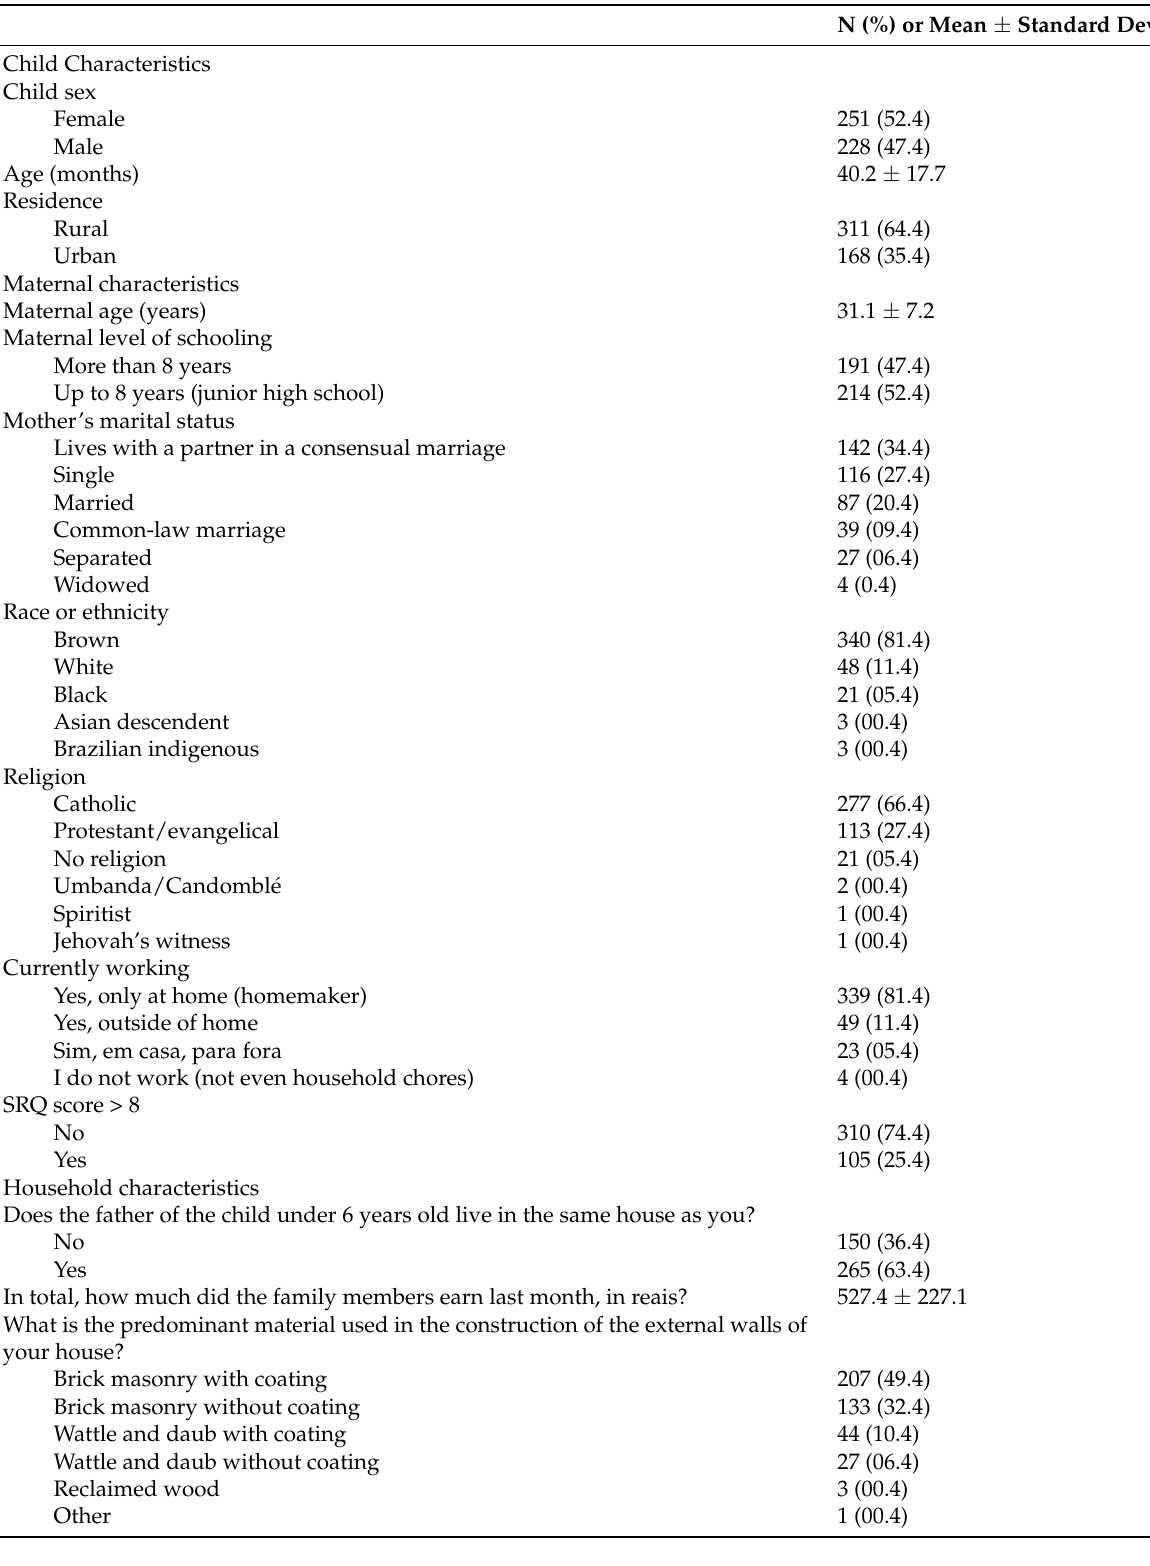
Table 1. Sociodemographic characteristics of the sample of mother-child